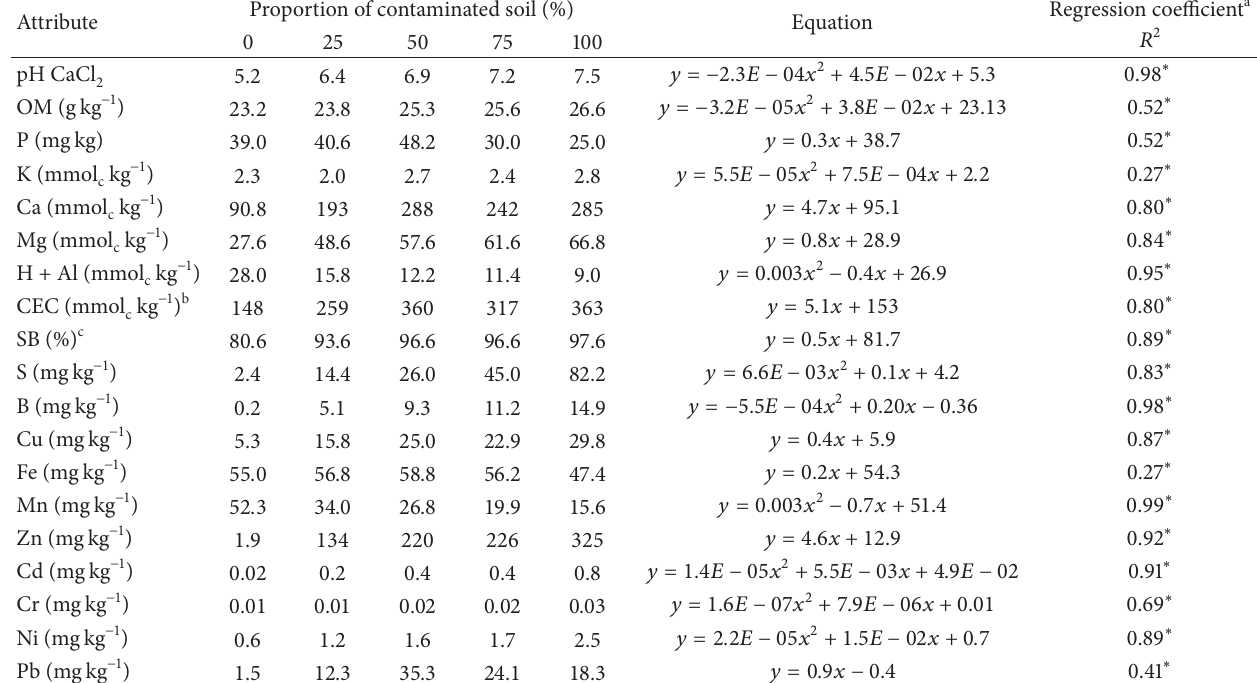
Table 3: Soil fertility and available content of heavy metals in the soil mixtures used in the experiment (after incubation). Proportion of contaminated soil (%) Attribute